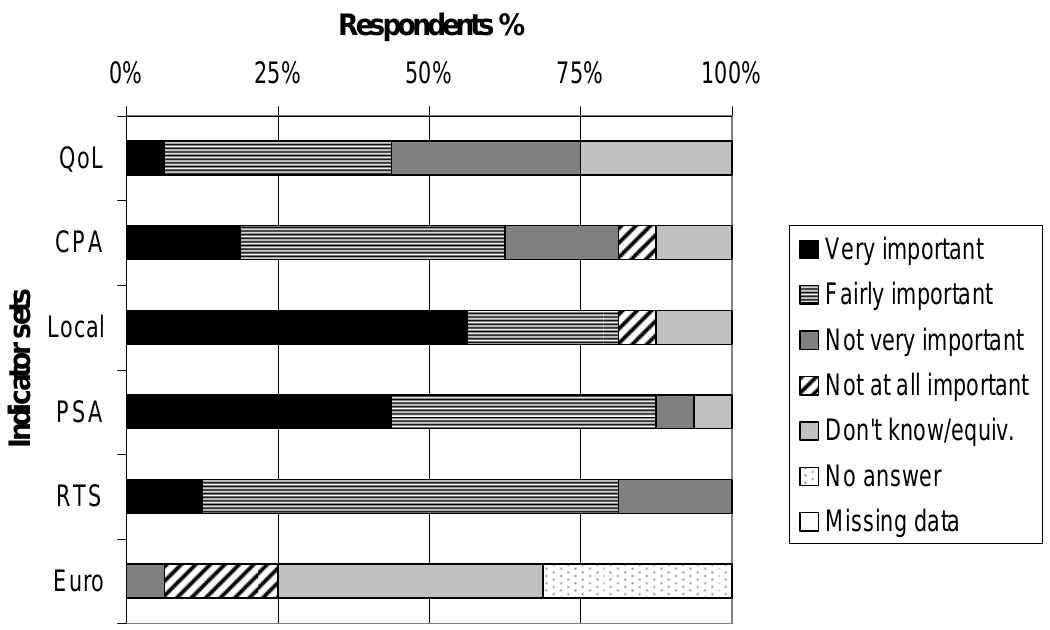
Figure 1. Importance of different indicator sets to DISTILLATE partner authorities 3 Source: Hull and Tricker,